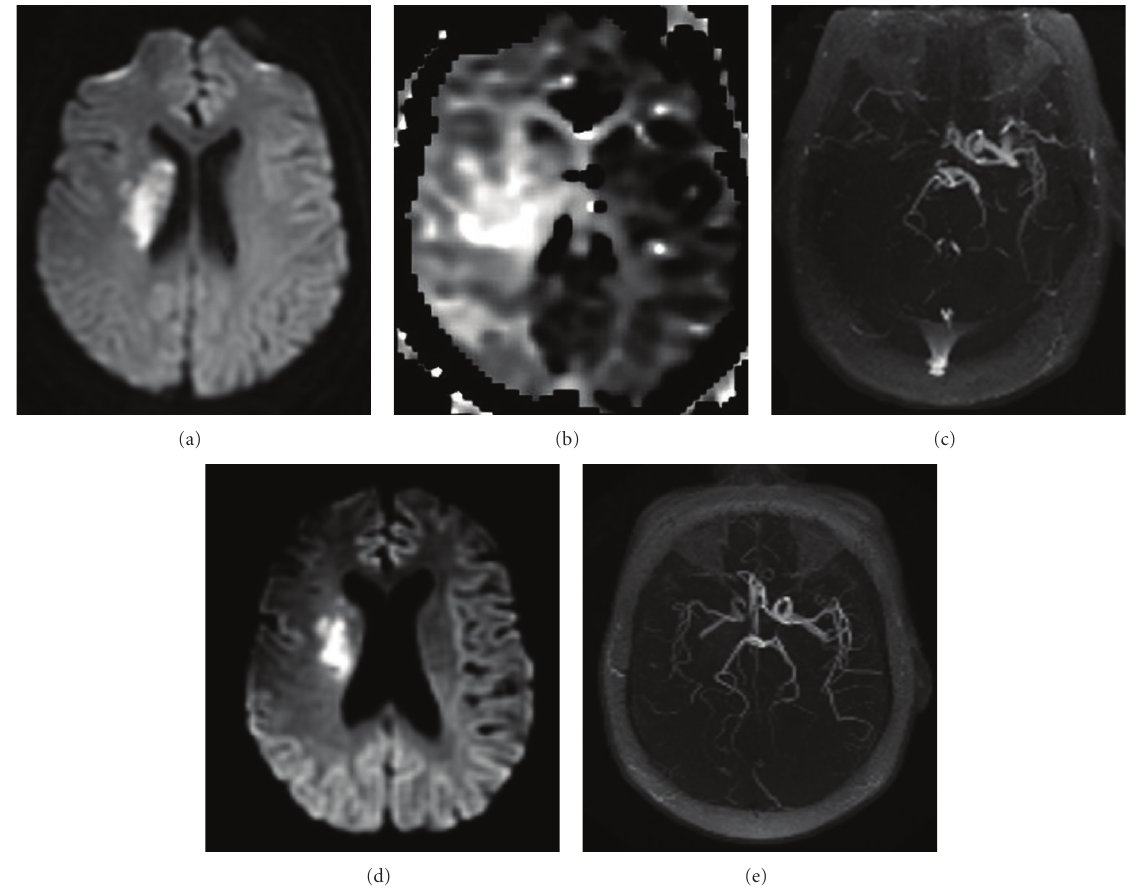
Figure 1: Magnetic resonance imaging of the brain, (a) prethrombolysis di ff usion-weighted image (DWI) shows brain infarct in the right MCA territory, (b) prethrombolysis Perfusion-weighted image (PWI) shows right brain hemisphere with perfusion defect, (c) prethrombolysis Magnetic resonance Angiography (MRA) shows absence of blood flow in the right MCA, (d) postthrombolysis DWI shows no significant interval changes in brain parenchyma, and (e) postthrombolysis MRA with patent right MCA.